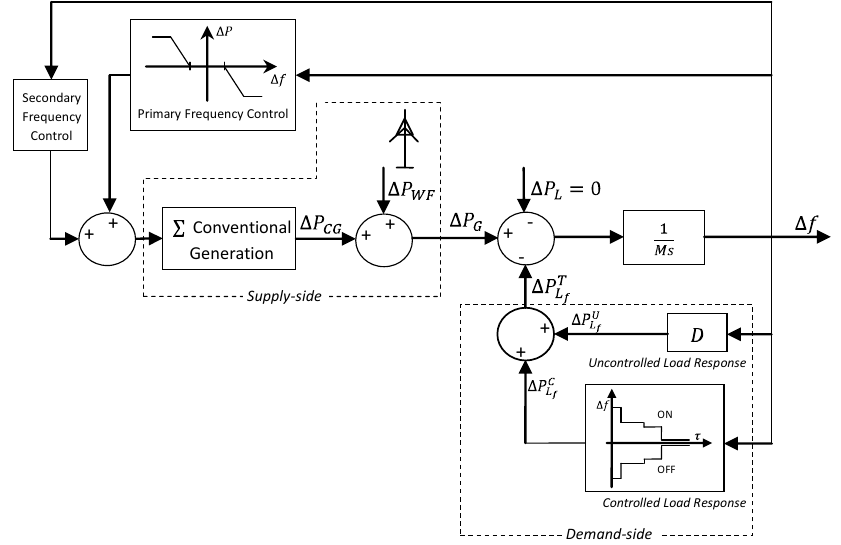
Figure 2. General scheme of the power system with the demand-side contribution to primary frequency control and wind power